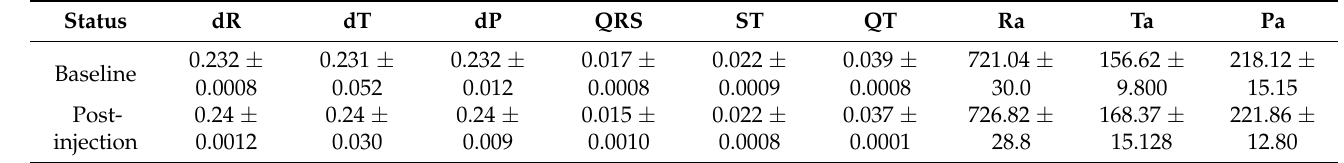
Table 9. Impact of compound 1 on ECG parameters in rats.